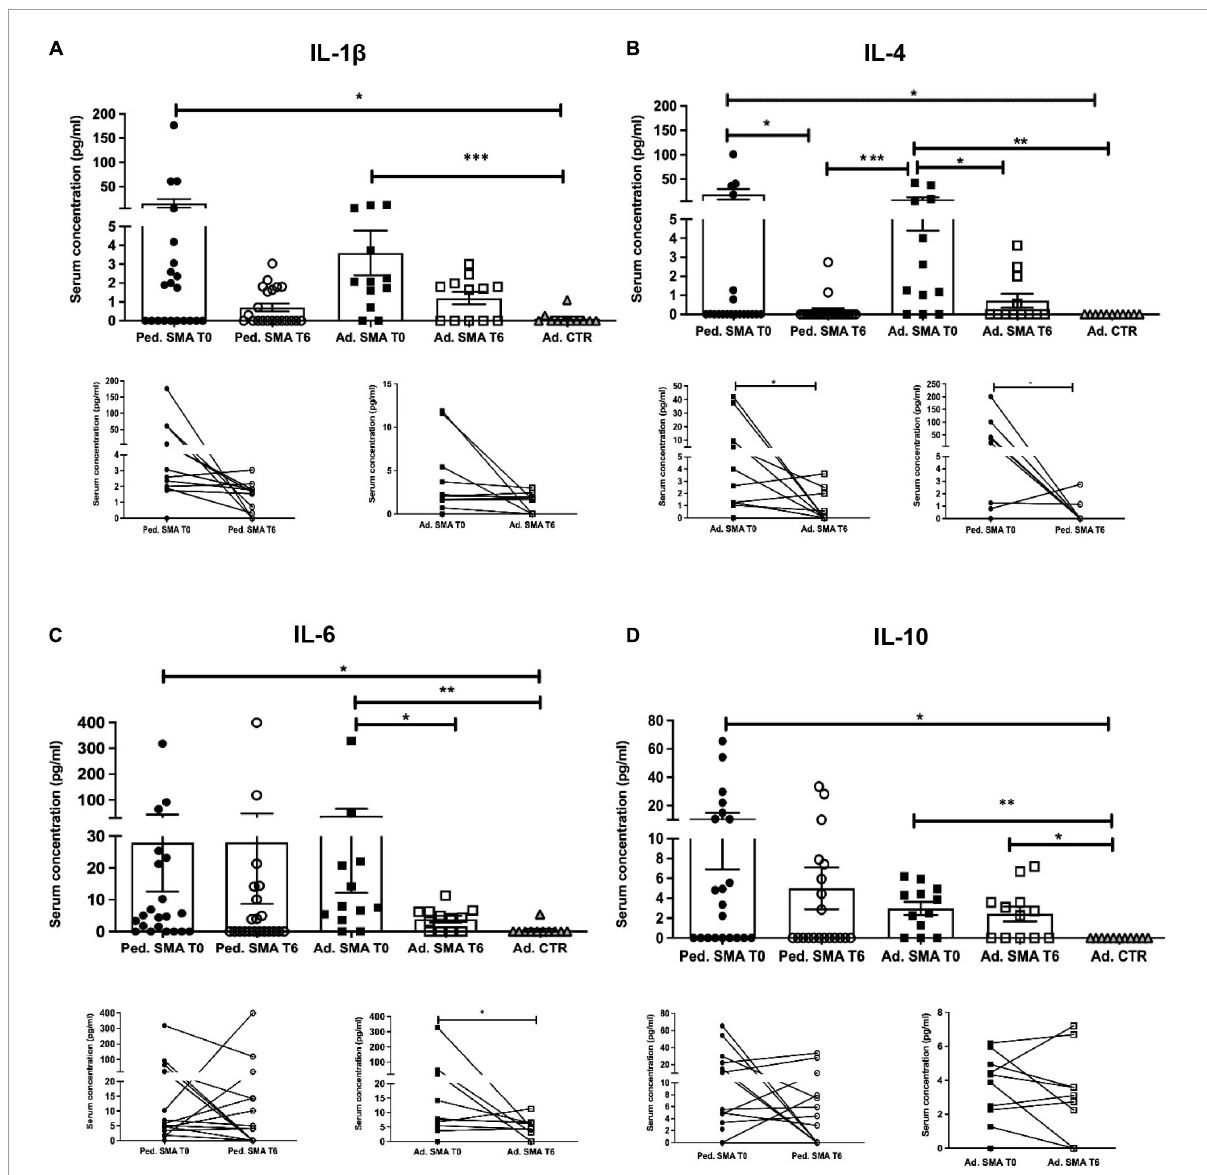
FIGURE1 Levels of cytokines in the serum of pediatric and adult spinal muscular atrophy (SMA) patients. The concentration (pg/ml) of (A) IL-1 β , (B) IL-4, (C) IL-6, and (D) IL-10 was measured in the serum of pediatric (Ped.; circle, N = 21) and adult (Ad.; square, N = 12) SMA patients at baseline (T0 black) and after 6 months of nusinersen treatment (T6 white), and in healthy controls (triangle) by multiplex immunoassay. Data in the graphs are reported as mean ± SEM for each sample group. The before-after graphs contains the mean cytokine concentration obtained for each patient in the duplicate multiplex immunoassays reactions before and after 6 months of nusinersen treatment (T0 and T6). * p < 0.05, ** p < 0.001, p < 0.0001*** by Mann–Whitney